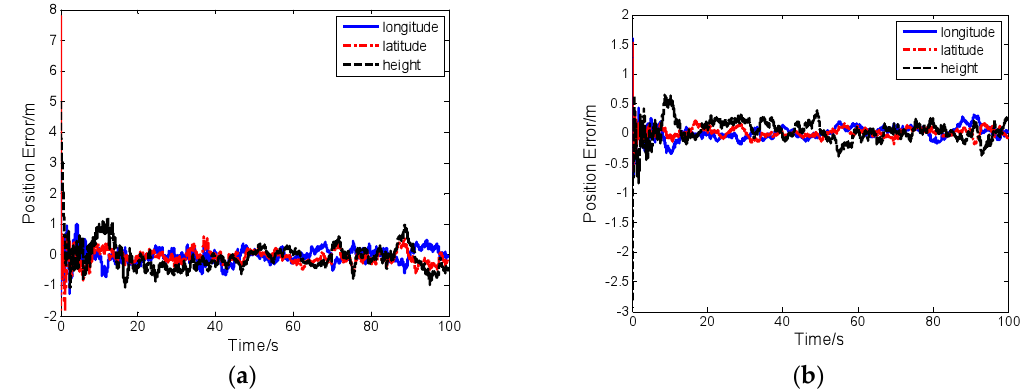
Figure 15. ( a ) Position error of the conventional ultra-tight integration. ( b ) Position error of our proposed ultra-tight integration.